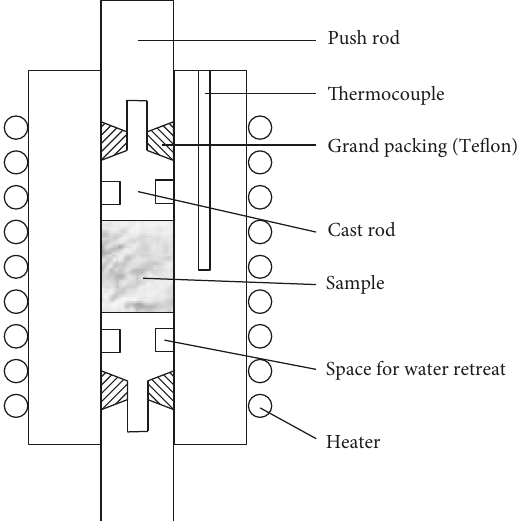
Figure 1: Hydrothermal hot pressing